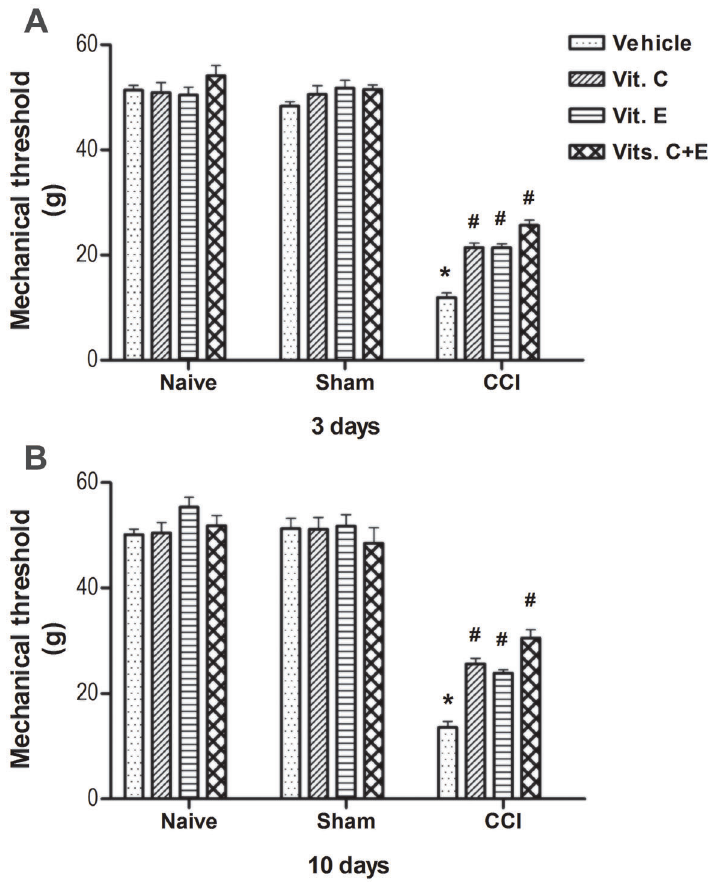
blotted wet weight of the spinal cord portion, E is the extinction coef fi cient of blue formazan (i.e., 0.72 L (cid:1) mmol – 1 (cid:1) mm – 1 ), and l is the length of the light path. Results are reported as